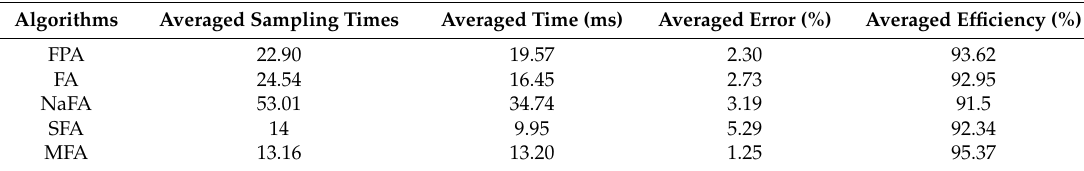
Table 10. Comparison of the simulation results of the five algorithms at 25 ◦ C.